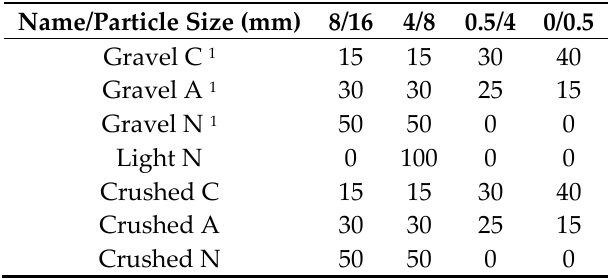
Table 1. Particle size distribution (given in percentage (%)) of the concrete